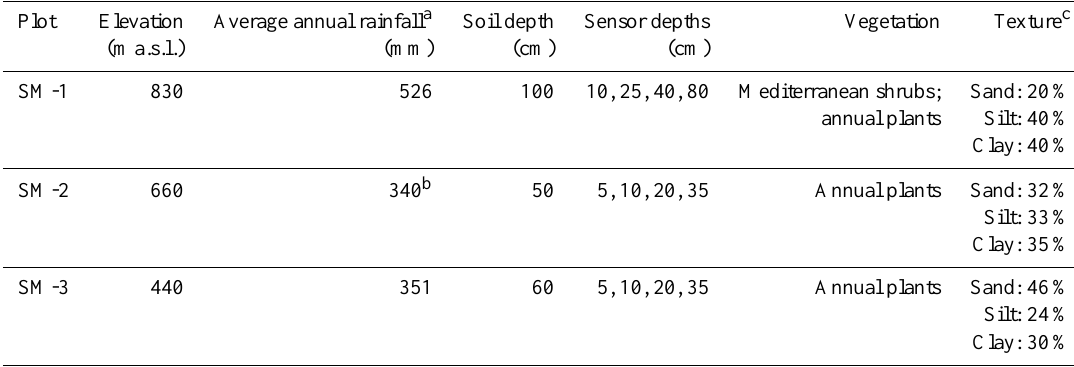
Table 1. Soil moisture plot characteristics. Plot Elevation Average annual rainfall a Soil depth Sensor depths